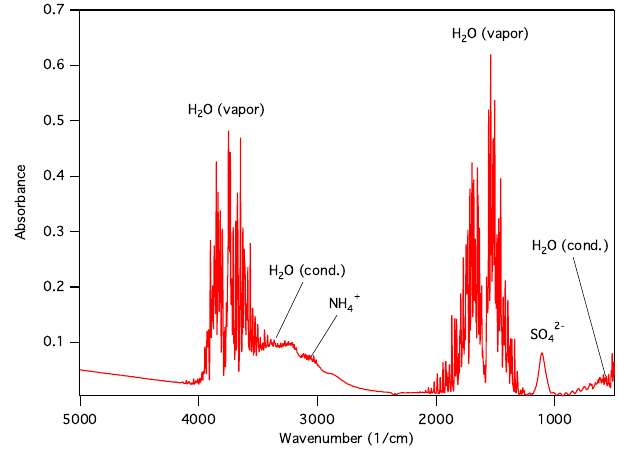
Figure 3. A typical FTIR spectrum of ammonium sulfate at high rel- ative humidity obtained in this experiment. Note the condensed- and gas-phase features. The slope at higher wavenumber corresponds to aerosol scattering.